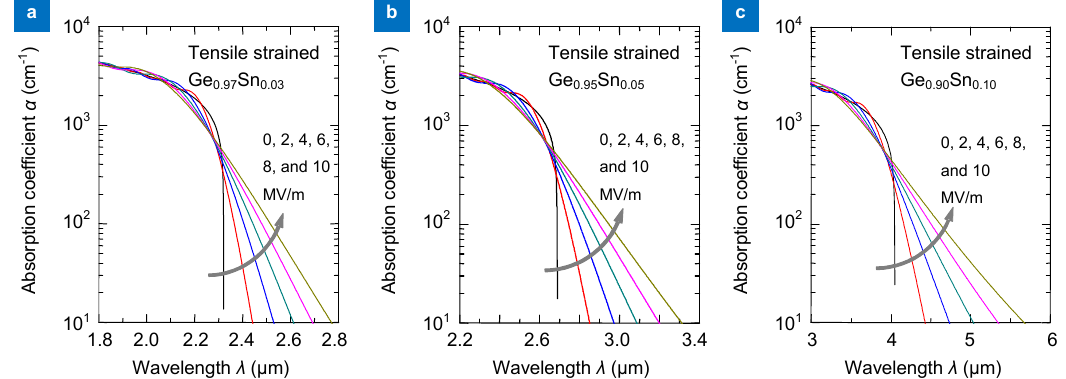
Fig. 4 | Modeled α as a function of wavelength at different electric fields at ( a ) Ge 0.97 Sn 0.03 , ( b ) Ge 0.95 Sn 0.05 , and ( c ) Ge 0.9 Sn 0.1 , respectively. Figure reproduced from ref. 26 , Optical Society of